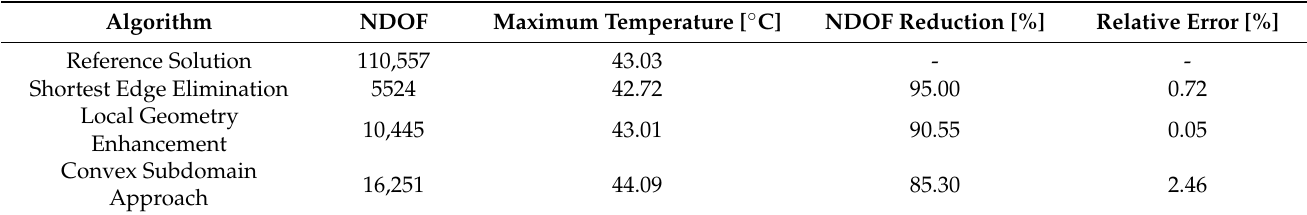
Table 1. Comparison of the results obtained for different algorithms (heat flow